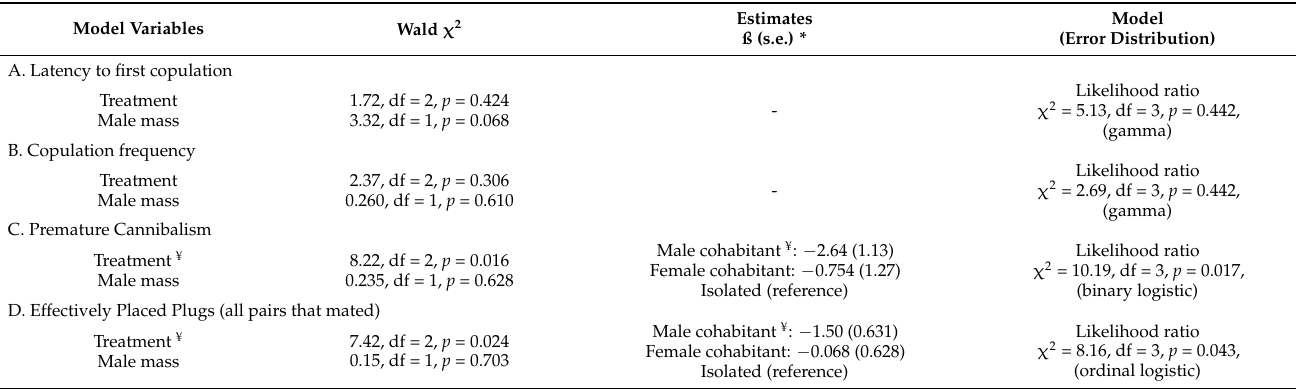
Table 2. Results of generalized linear model analyses examining the effects of the focal females’ cohabitation treatment on the outcome of successful mating trials, including the latency to copulation (A), the copulation frequency (B), the occurrence of premature cannibalism that terminated the mating (C), and the frequency of successful plug placement (D). Model Variables Wald χ 2 Estimates ß (s.e.) *